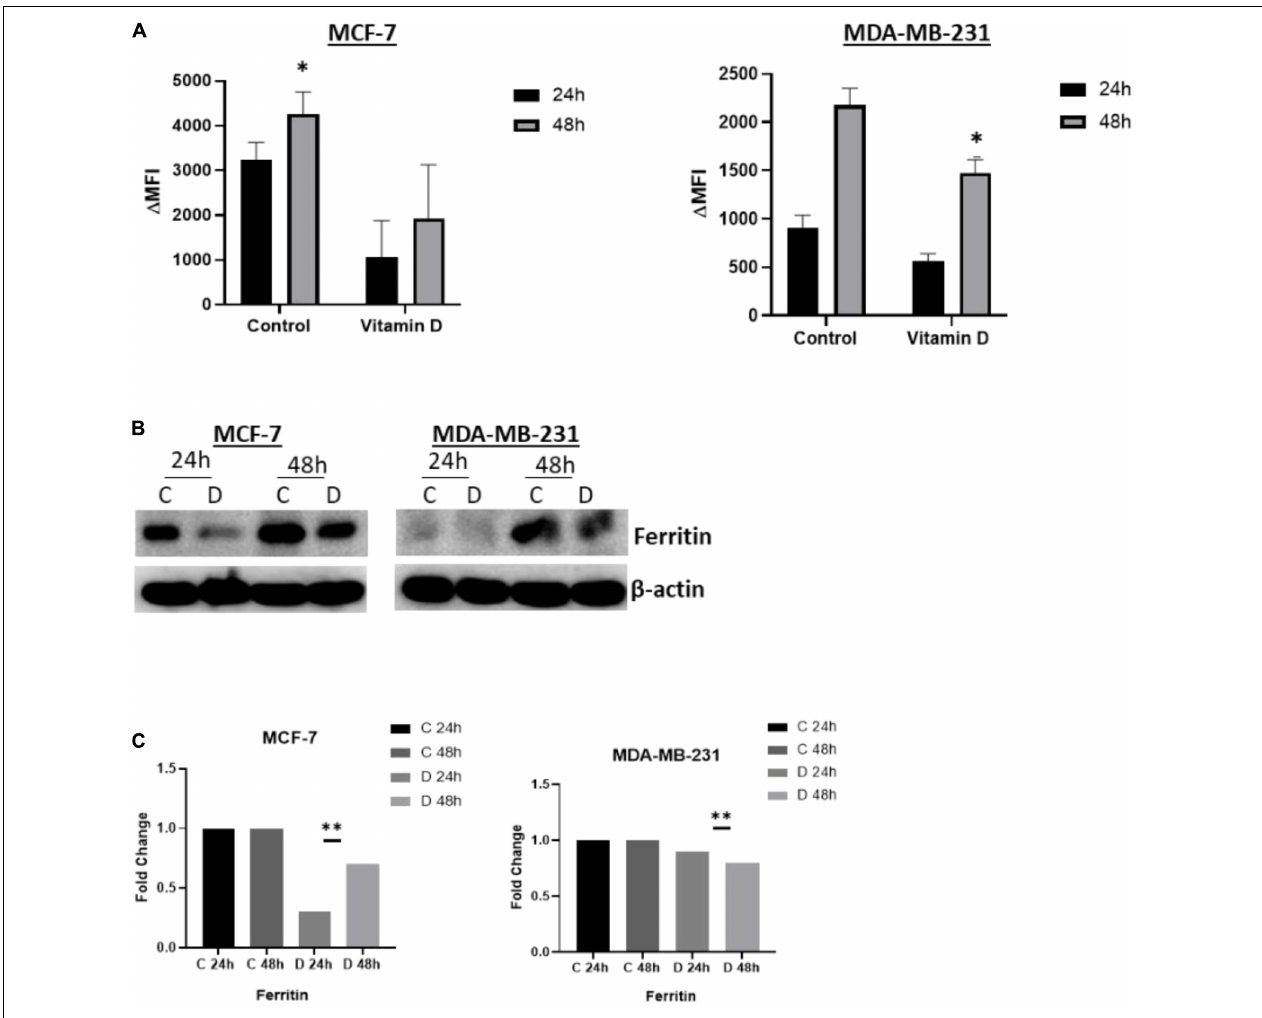
FIGURE 4 | Vitamin D depletes labile cellular iron in BRCA cells. (A) Calcein-based flow cytometry method was used to assess labile iron pool (LIP) content in MCF-7 and MD-MBA-231 cells treated with 10 µ M vitamin D. Difference in mean fluorescence intensity ( (cid:49) MFI) between calcein + chelator and calcein only is an indirect measurement of LIP content; the smaller the (cid:49) MFI value, the lower the LIP content. (B) Ferritin expression was assessed in cell lysates of MCF-7 and MDA-MB-231 cells at 24 and 48 h post vitamin D treatment; untreated cells served as controls. The data shown are the mean MFI ± SEM of four separate experiments. (C) Quantitative analysis of relative protein band density after normalization to β -actin and compared to the control. *Represents statistically significant change ( P < 0.05) and **Represents statistically significant change ( P <